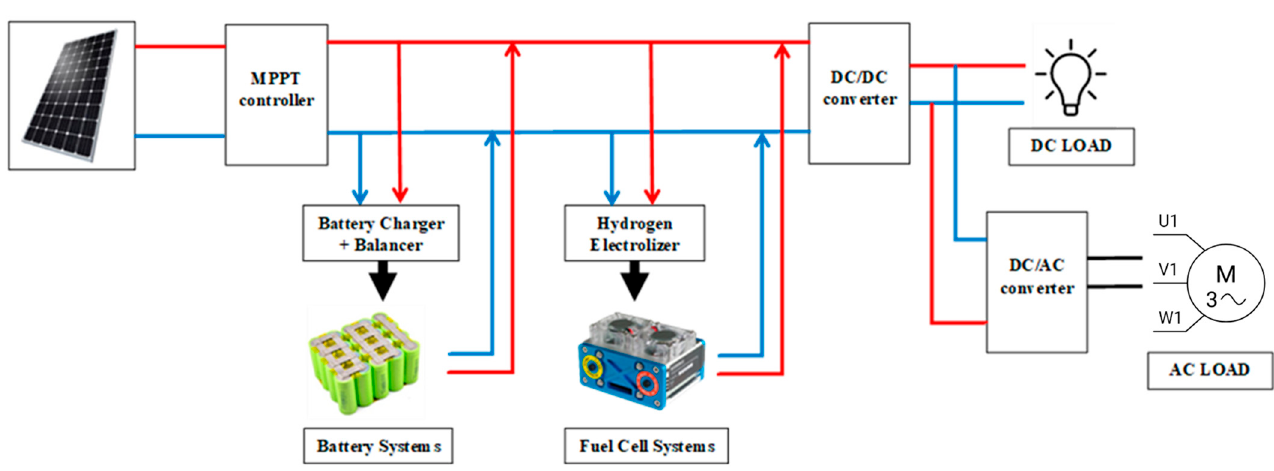
Figure 5. PV-based HRES systems